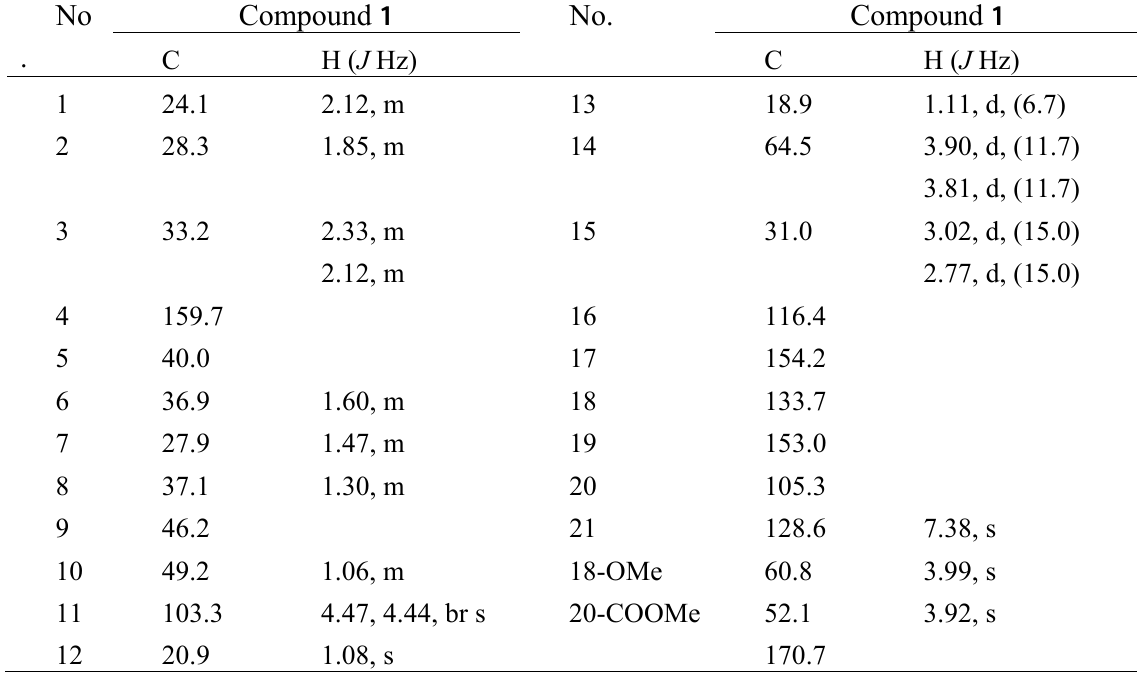
Table 1. 13 C-NMR (125 MHz) and 1 H-NMR (500 MHz) data of Compound 1 (CDCl